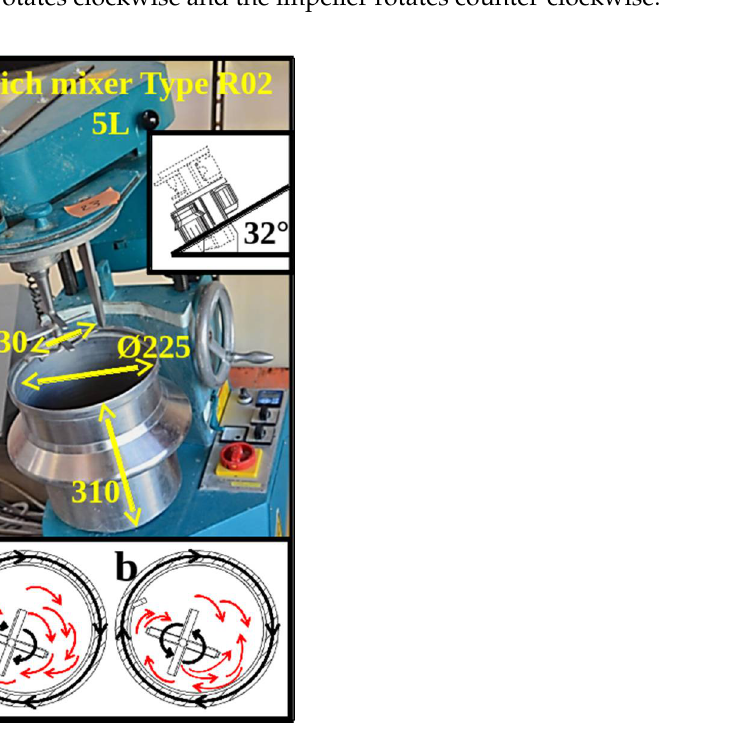
Figure 1. Laboratory mixer used in this study (a 5l intensive pan mixer, manufactured by Eirich Gmbh), illustrating the different modes of operation: co-current ( a ) and counter-current ( b